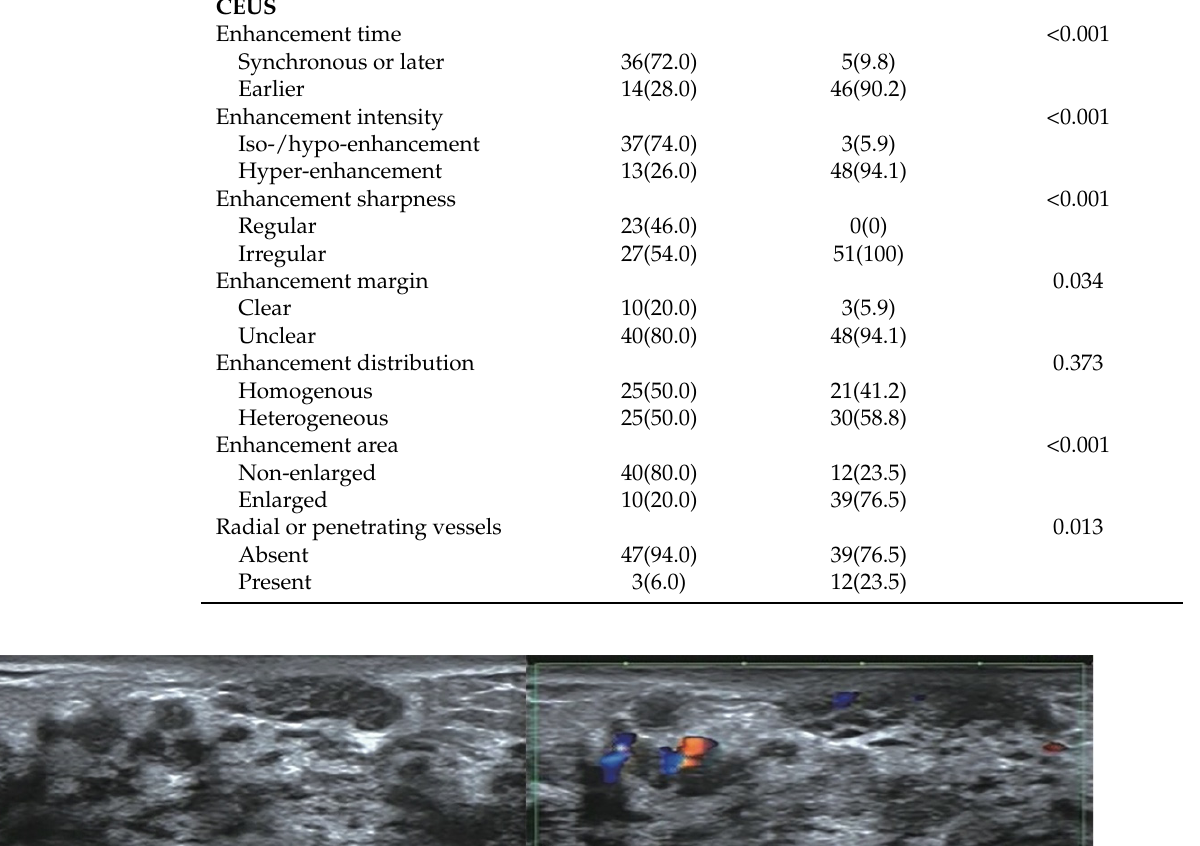
Figure 2. A 58-year-old female was diagnosed with DCIS with histopathology. ( a ) The conventional US image indicated a hypoechoic area at 12 o’clock direction of the left breast with ill-defined margins, irregular shape and microcalcifications; ( b ) The SE image showed more than half of the lesion area was blue with little green spots, scored as 4; ( c ) Under the CEUS pattern, the lesion showed early hyper-enhancement with unclear margin, irregular sharpness, enlarged enhancement area and radial or penetrating vessels; ( d ) Histopathological analysis revealed DCIS (hematoxylin- eosin stain; original magnification, ×100). 3.3. Developing the Prediction Model All the features acquired from single factor analysis were included in the regression analysis as independent variables. Then in the multivariate analysis with the stepwise forward variable selection method, all independent risk factors for malignant NMLs were determined in the final step as follows: age ≥ 45 y (OR: 11.70, p = 0.028), microcalcifications in the lesion on conventional US (OR: 12.03, p = 0.018), elasticity score >3 on SE (OR: 27.88, p = 0.008), earlier enhancement time (OR: 39.95, p = 0.006) and hyper-enhancement on CEUS (OR: 13.37, p = 0.014). A logistic regression equation was finally established with the significant predictors as follows: p = 1/1 + Exp  [ − 7.869 + 2.459 × (if age ≥ 45 y) + 2.487× (if microcalcifications in the lesion) + 3.328 × (if elasticity score >3) + 3.688 × (if earlier enhancement time) + 2.593 × (if hyper-enhancement)]. The area under the ROC curve (AUC) using this formula was